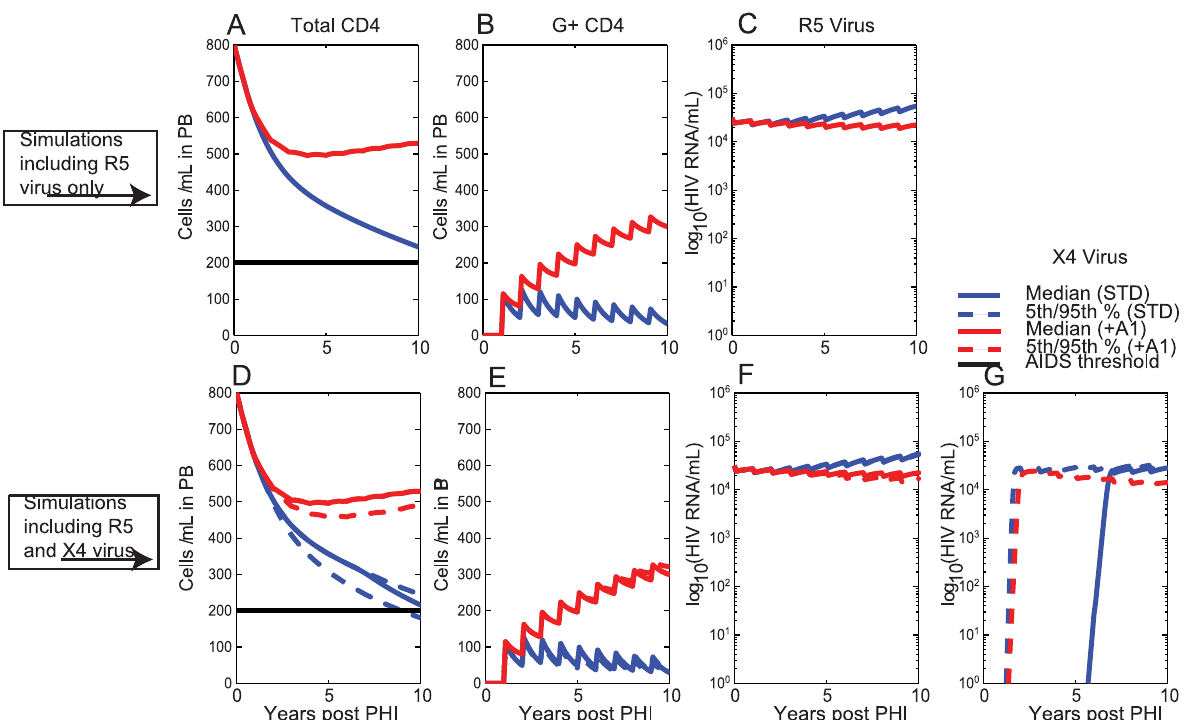
Figure 5. Repeated annual delivery of gene therapy to CD4 + T cells assuming that 20% of CD4 + T cells receive the gene construct every year from year 1 (i.e. every year, starting from year 1, 20% of G- CD4 + T cells become G + CD4 + T cells). Therapy is first administered at year 1 and then annually thereafter. Shown are the simulation outcomes under the standard scenario (STD) and also under Assumption + A1 of reduced bystander apoptosis in G + CD4 + T cells ( + A1); Solid lines denote median values, dashed lines denote 5 th and 95 th percentiles for outcomes when 6 4 virus can develop. Also shown is the AIDS threshold of 200 cells/ m L (solid horizontal black line); A) Total CD4 + T cell count, B) G + CD4 + T cell count and C) R5 Viral Load for a single simulation with R5 virus only (i.e. assuming V X 4 t ð Þ ~ 0 throughout the course of infection); D) Total CD4 + T cell count, E) G + CD4 + T cell count F) R5 Viral Load and G) 6 4 Viral Load for Monte Carlo simulations assuming initial infection with R5 virus, but now including 6 4